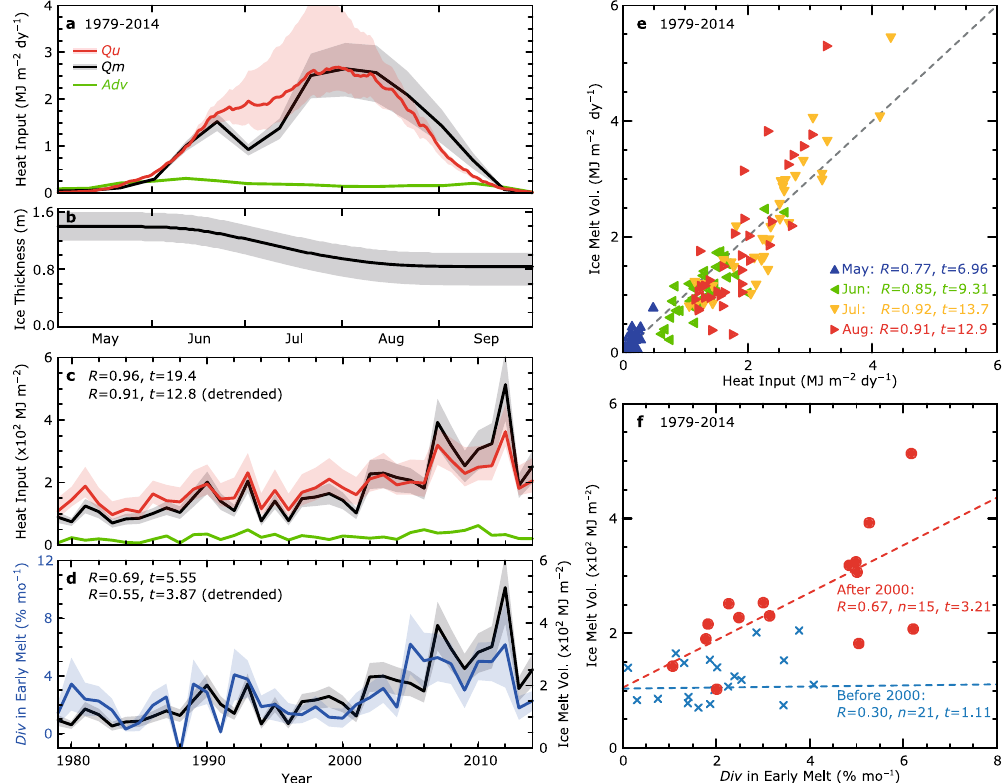
Figure 2. Results of heat and sea ice budget analyses. Seasonal evolutions of ( a ) heat input through the open water fraction ( Qu , red line), ice melt volume ( Qm , black line), and the volume of ice export ( Adv , green line), and ( b ) mean ice thickness calculated from the surface melt by heat input at the ice surface. The volume of ice is converted to the heat required for the equivalent amount of ice melt. ( c ) Interannual variations in Qu , Qm , and Adv accumulated from May to August. ( d ) Interannual variations of ice divergence ( Div ) averaged from mid- May to early-June (blue line) and yearly Qm . ( e ) Scatter plot of Qu and Qm . Monthly means (May to August) for each year are plotted. ( f ) Scatter plot of Div averaged from mid-May to early-June versus yearly Qm . Blue crosses and red circles indicate values before and after 2000, respectively. Dashed lines indicate the regression line for both periods. Uncertainties due to errors in the satellite observations are shown as shaded envelopes (see